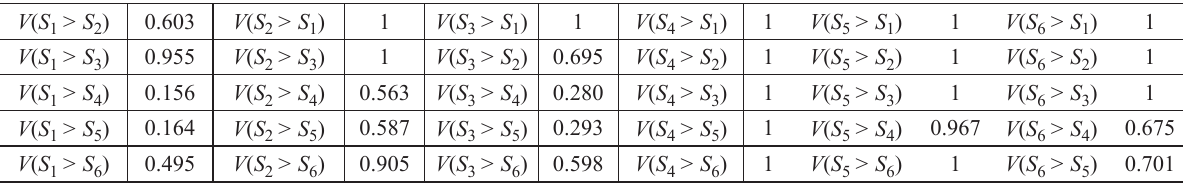
Table 5. The degree possibility for convex fuzzy numbers for the pairwise comparisons criteria with related to